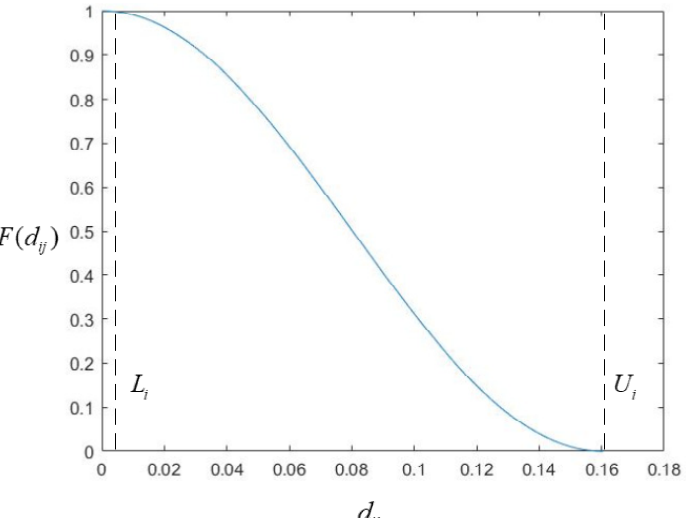
Figure 1. User satisfaction evaluation function.